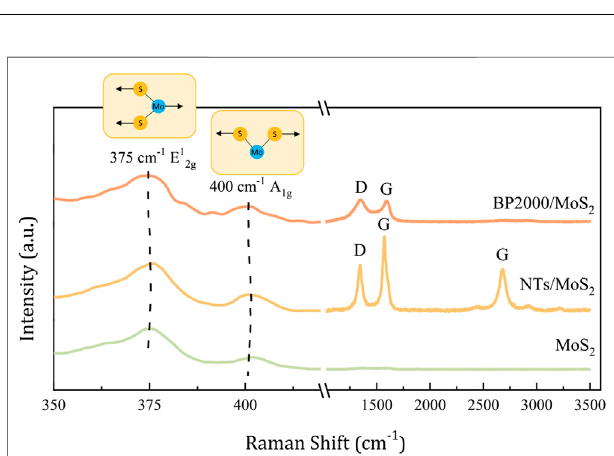
FIGURE 1 | Simpli fi ed process of carbon/MoS 2 synthesis.